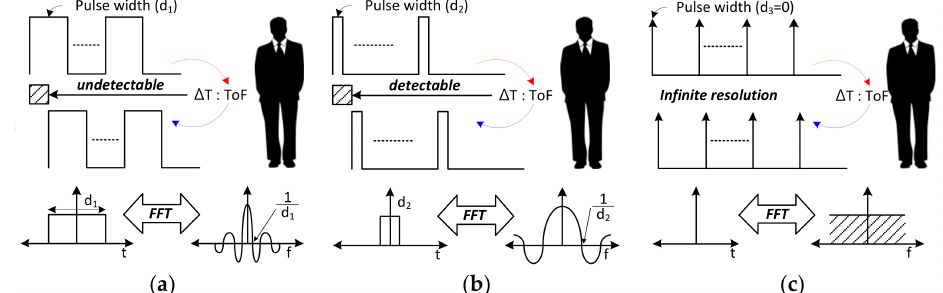
Figure 2. Relationship between frequency bandwidth and range resolution. ( a ) In the case where the pulse width of the transmitted signal has the largest pulse width; ( b ) In the case where the pulse width of the transmitted signal is narrower than that in the previous condition; ( c ) As the most ideal condition, the transmitted signal is a